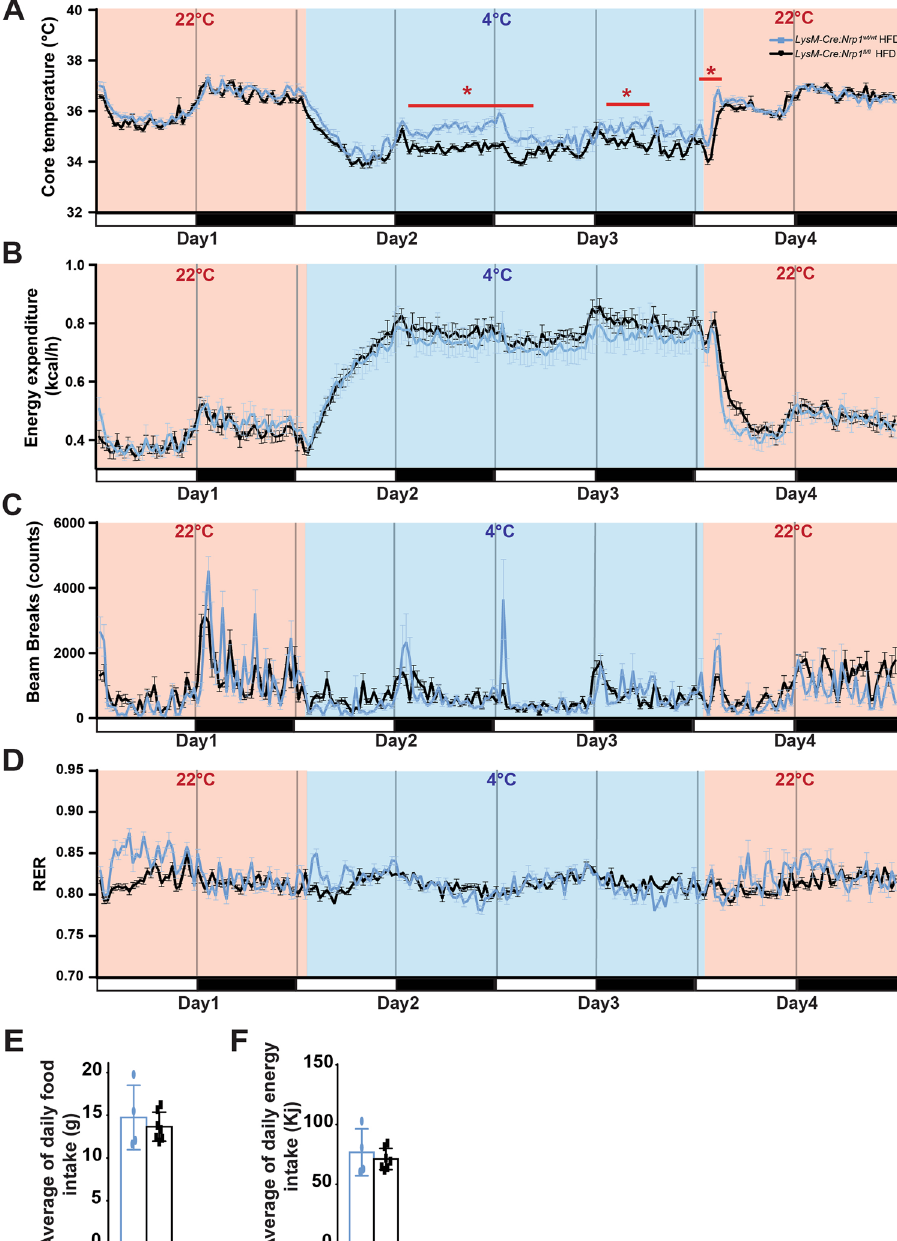
Figure 3. LysM-Cre:Nrp1 fl/fl mice have a decreased core temperature during cold exposure. ( A ) Core temperature, ( B ) Energy expenditure, ( C ) Beam breaks and ( D ) RER of LysM-Cre:Nrp1 wt/wt and LysM- Cre:Nrp1 fl/fl mice fed a high fat diet after 12 weeks of diet, n = 4 mice for LysM-Cre:Nrp1 wt/wt and n = 7 for LysM-Cre:Nrp1 fl/fl . ( E ) Average of daily food intake and ( F ) Average of daily energy intake of LysM-Cre:Nrp1 wt/wt and LysM-Cre:Nrp1 fl/fl mice fed a high fat diet after 10–12 weeks of diet, n = 4–7 mice per genotype. Data are presented as mean ± SEM. * p < 0.05; ** p <